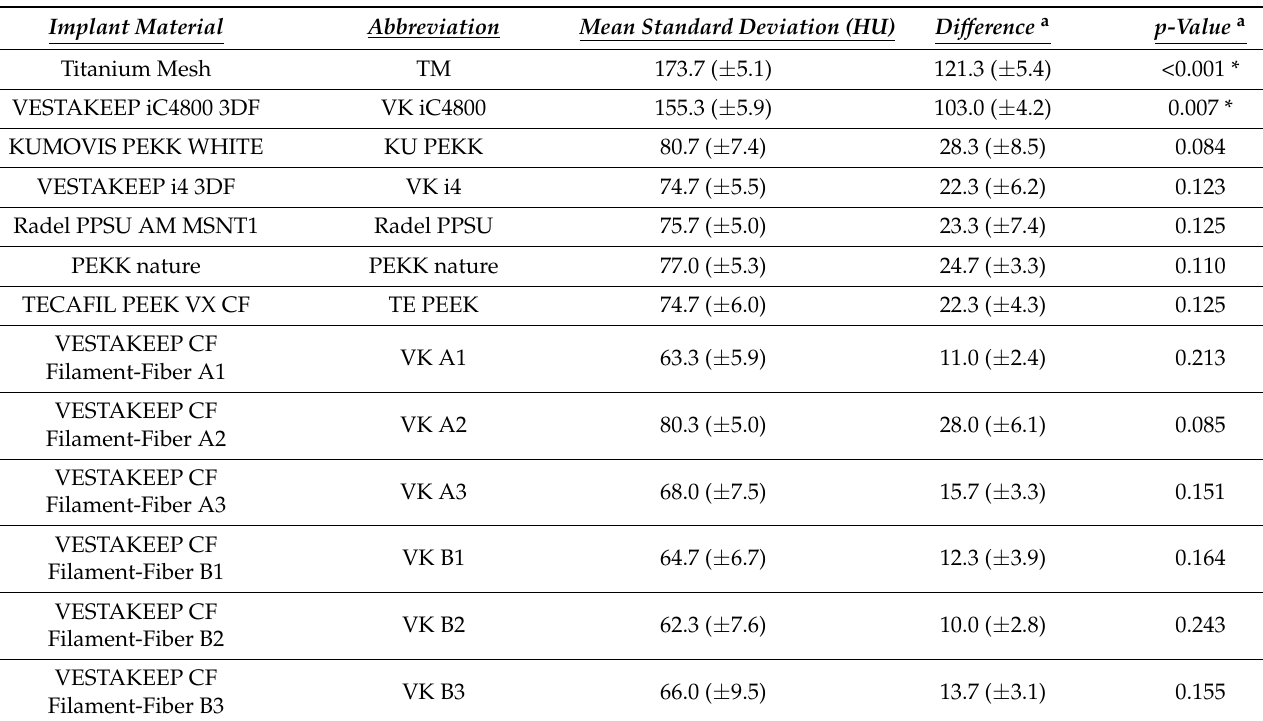
Table 2. Display of implant materials, mean standard deviation of Hounsfield Units (HU) and their difference to control as well as respective p